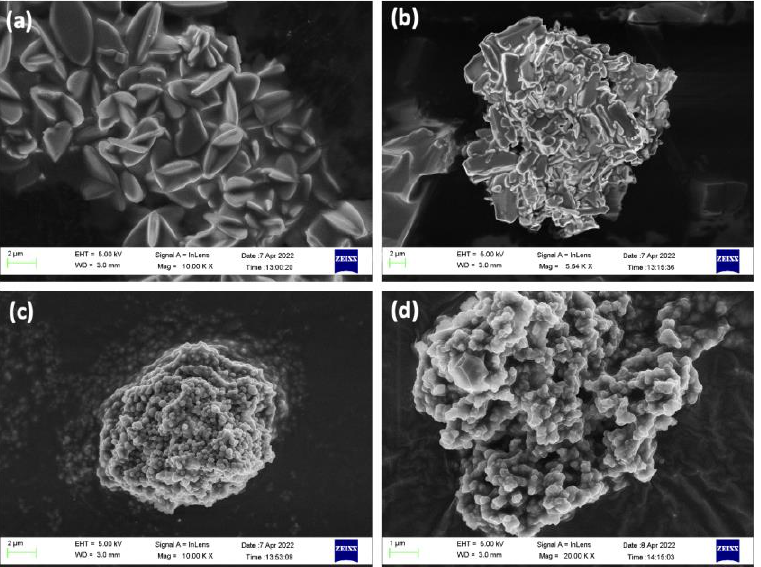
Figure 8. SEM images of ( a ) CIP/ZIF (0.007 mg/mg); ( b ) CIP/ZIF (2 mg/mg); ( c ) magnetic ZIF-8; and ( d ) magnetic CIP/ZIF (0.6 mg/mg).